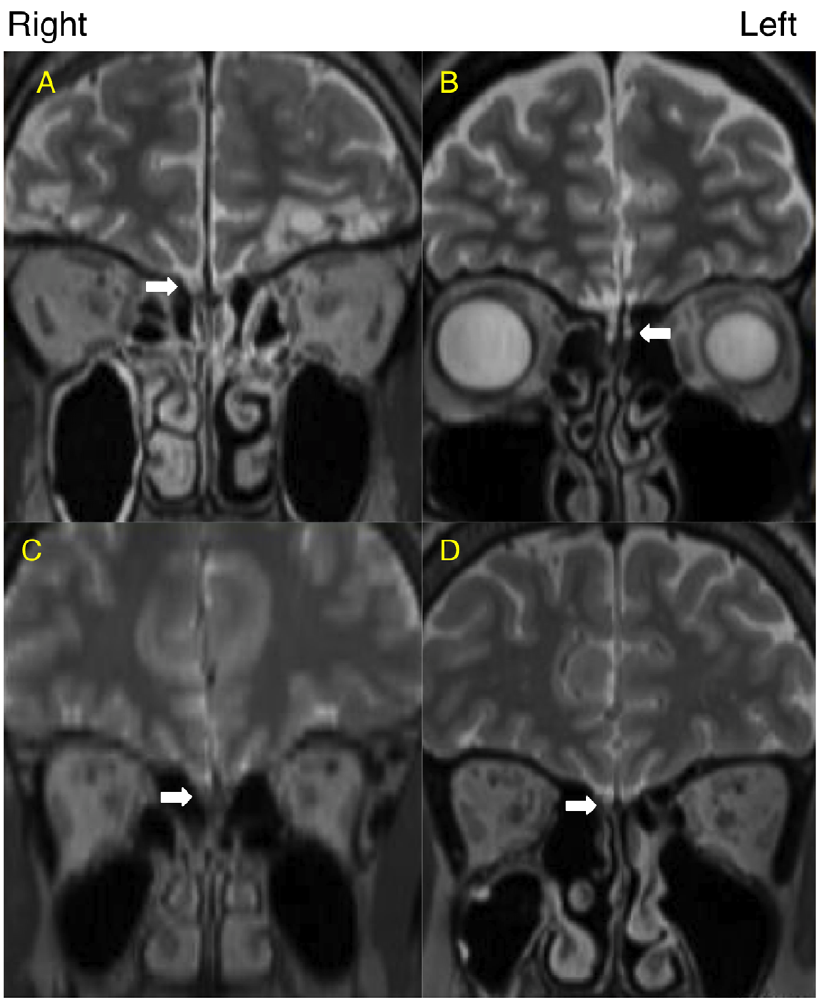
Figure 3. MRI image (T2 weighted, coronal view). White arrows indicate the olfactory bulb and olfactory nerve. (A) A 60-year-old healthy male volunteer. (B) A 44-year-old female with hyposmia after head trauma. (C) A 42-year-old female with hyposmia after upper respiratory tract infection. (D) A 67-year-old female with hyposmia due to chronic rhinosinusitis. doi:10.1371/journal.pone.0057671.g003 PLOS ONE |